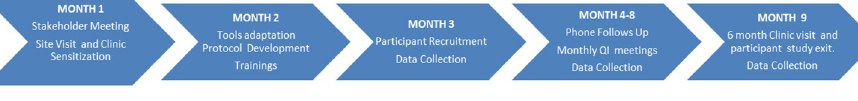
Fig 2. Project implementation